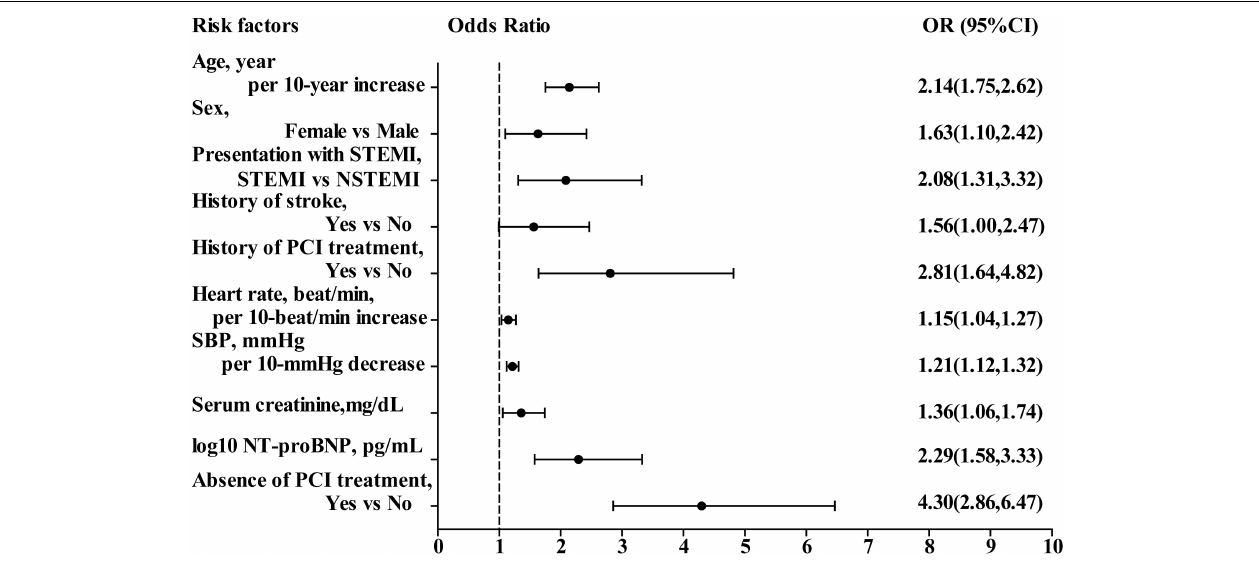
FIGURE 2 | Odds ratio of in-hospital mortality in multivariate logistic regression model. OR, odds ratio; CI, confidence interval; STEMI, ST-segment elevation myocardial infarction; NSTEMI, non-ST-segment elevation myocardial infarction; SBP, systolic blood pressure; NT-proBNP, N-terminal pro-B-type natriuretic peptide; PCI, percutaneous coronary